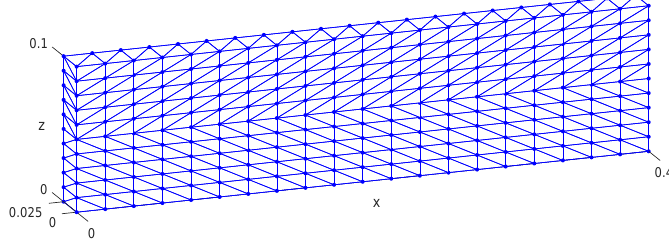
Figure 4. Finite element model of a shape memory alloy beam with the initial mesh layout (Example 3).